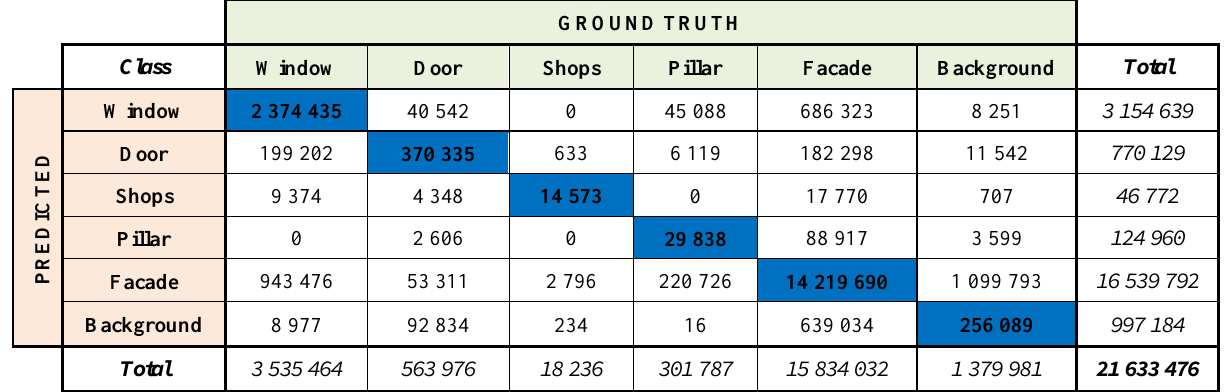
Table 1. Confusion matrix of the classification results. True positive values are highlighted in blue.